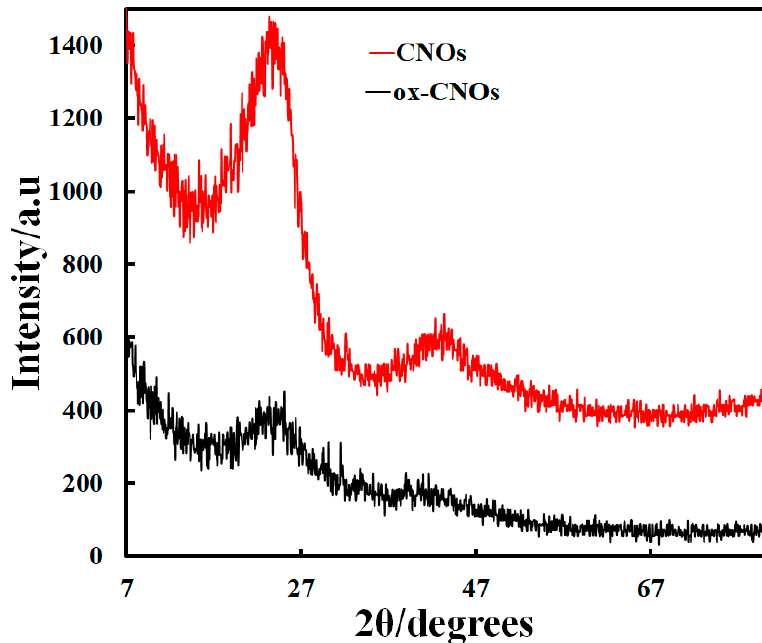
Figure 3. XRD pattern of CNOs and ox-CNOs.